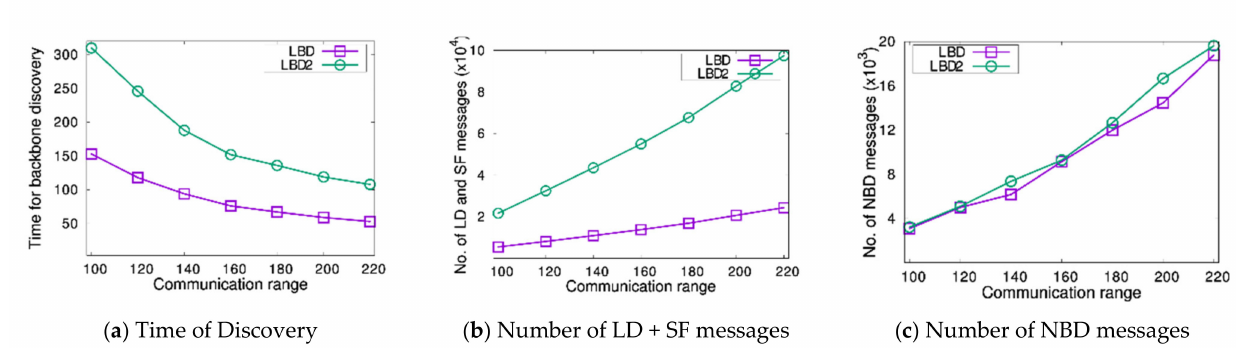
Figure 7. Performance results of the LBD and LBD2 algorithms as the communication range increased with the number of sensor nodes fixed at 1000. ( a ) Time of Discovery ( b ) Number of LD + SF messages ( c ) Number of NBD